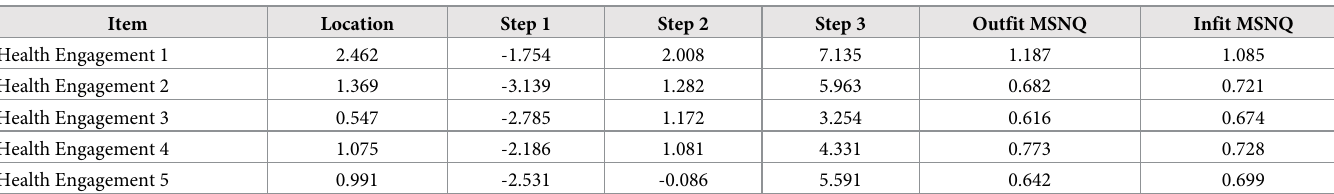
Table 4. Partial credit model and item fit statistics.